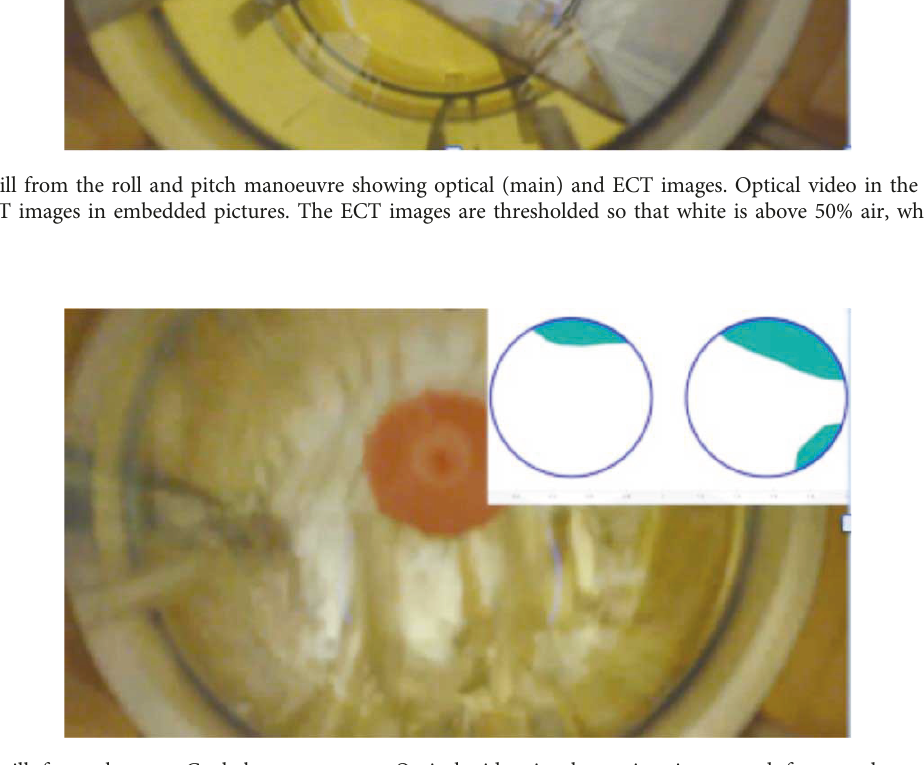
Figure 4: Video still from the zero-G shake manoeuvre. Optical video in the main picture and front and rear ECT images in embedded